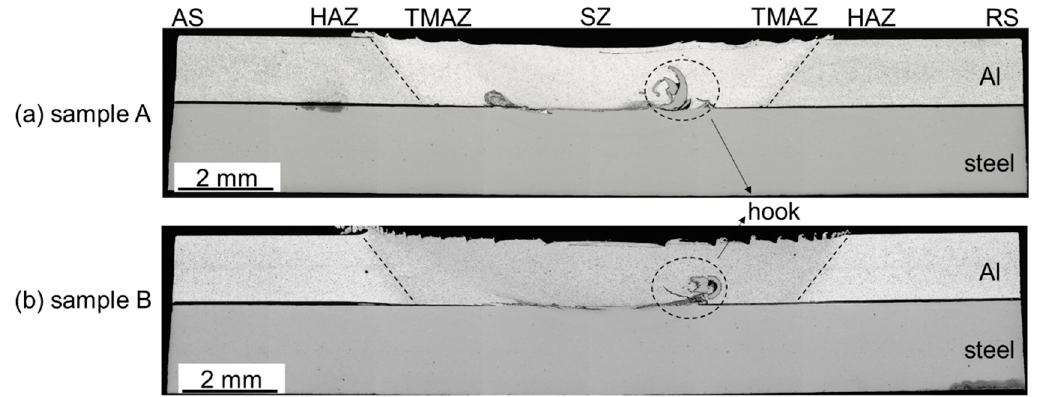
Figure 7. Cross-sectional macrostructures of ( a ) specimen A and ( b ) specimen B. (AS: advancing side, RS: retreating side).